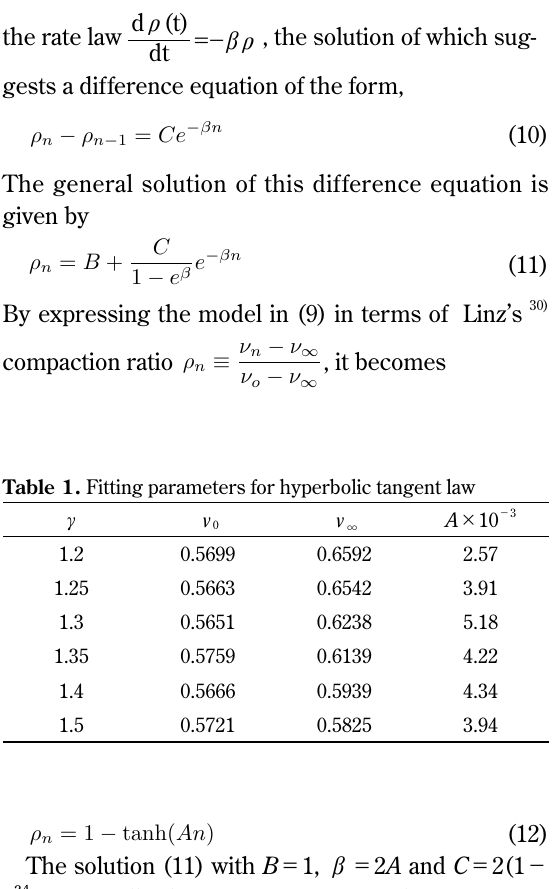
Fig. 8 Comparison of the evolution of the ensemble-averaged bulk solids fraction at intensity γ＝ 1.25 with( × ) and without( □ ) the application of random lateral displacements. The results with and without these displacements are statistically indistinguishable.